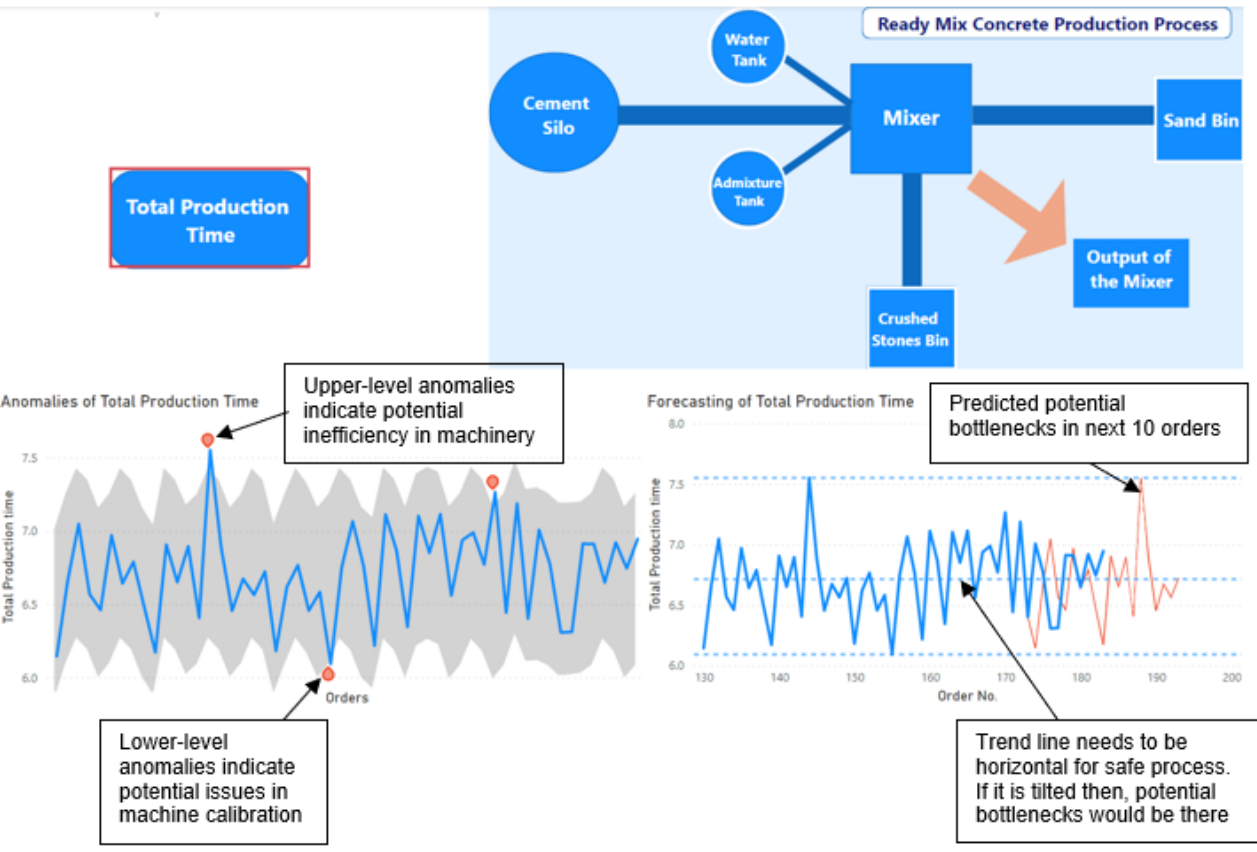
Figure 18. DT Dashboard with Predictive Analytics.